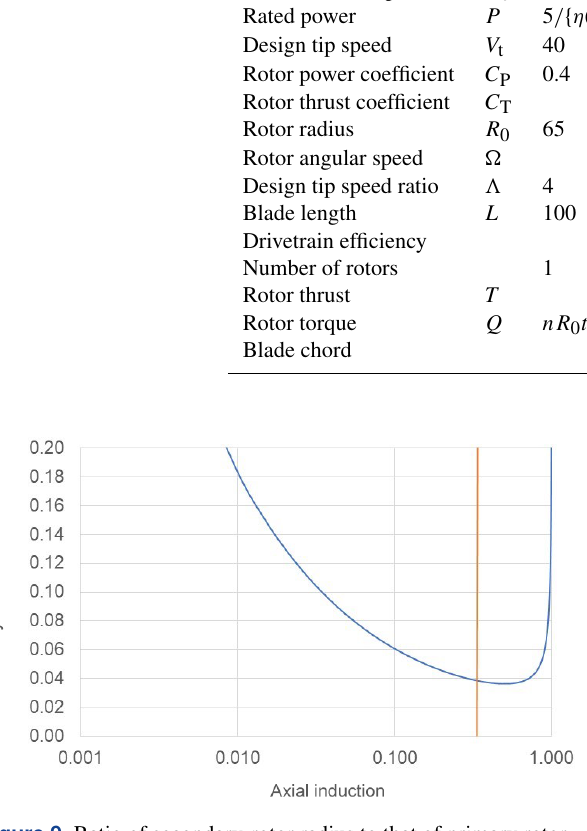
and the associated radius fraction is 0.084. Each secondary rotor then has a radius ( ∼ 5 m) that is 8.4 % of the primary- rotor radius (60